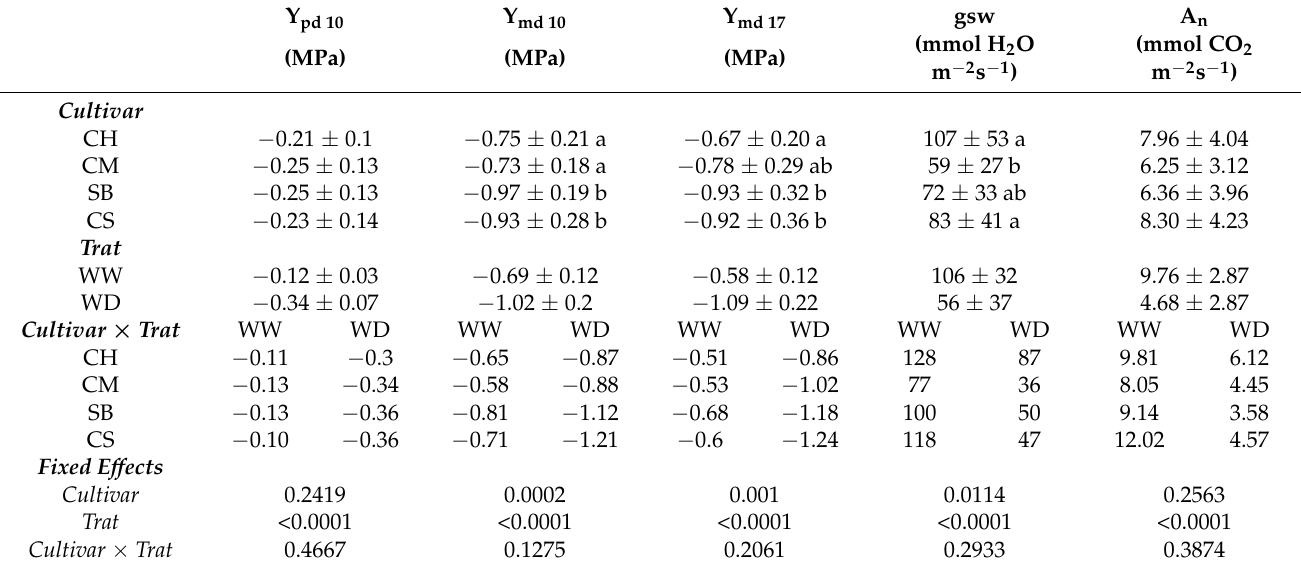
Values correspond to mean ± SD. Also, for p -values < 0.05 for fixed effects, post hoc Tukey’s honestly were tested. Different letters indicate significative differences between